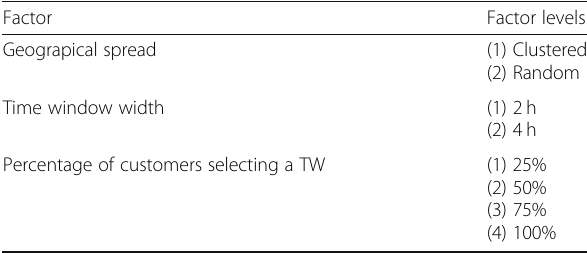
Table 1 Experimental factor setting (design 1: percentage